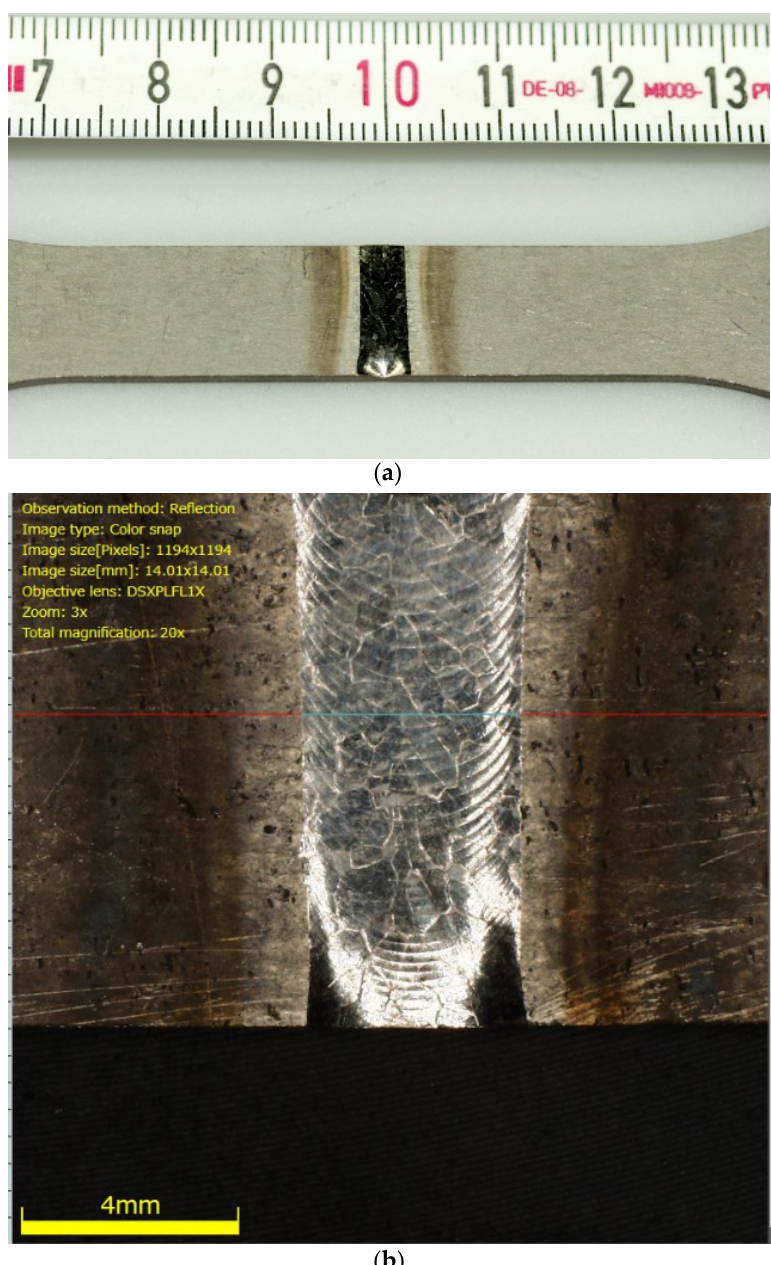
Figure 10. Macroscopic images of Type 2 specimen ( a ) and detailed image of its weld bead; ( b ) before fatigue cracks.